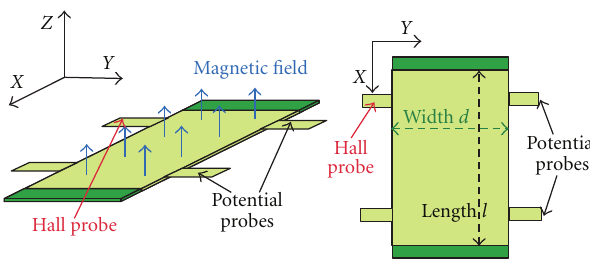
Figure 1: Quantum hall